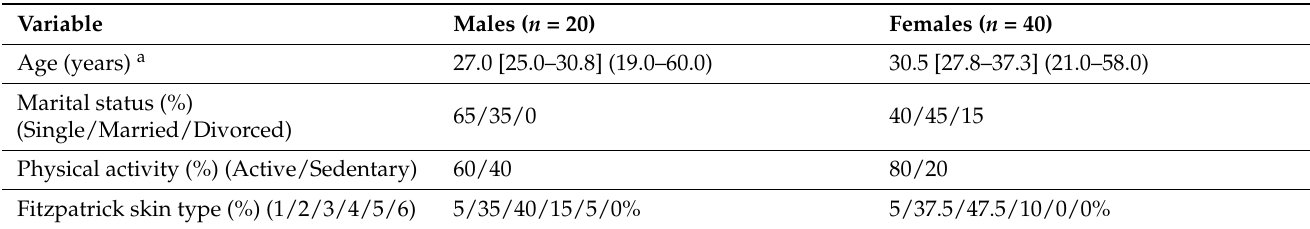
Table 1. Demographic parameters of the included